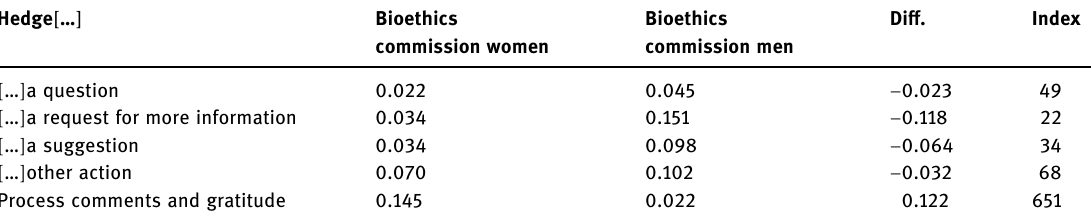
Table 11: Frequency of “ I would like ” concordance types, as a per cent of total tokens ( normalised, n = 1,000 ) Hedge [ …